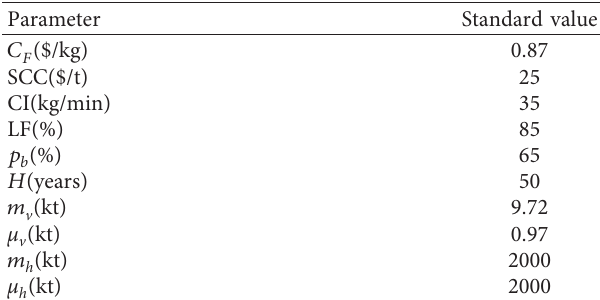
Table 3: Standard values of parameters used in benchmark